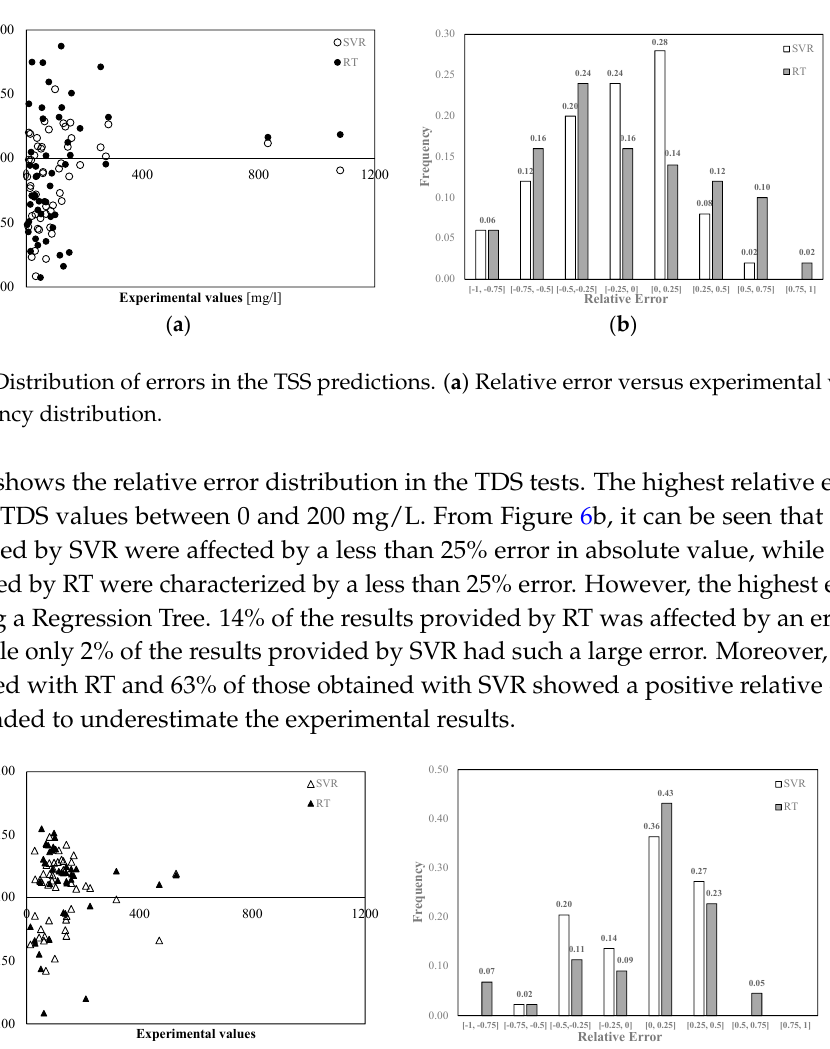
Figure 6. Distribution of errors in the TDS predictions. ( a ) Relative error versus experimental values; ( b ) Frequency distribution.